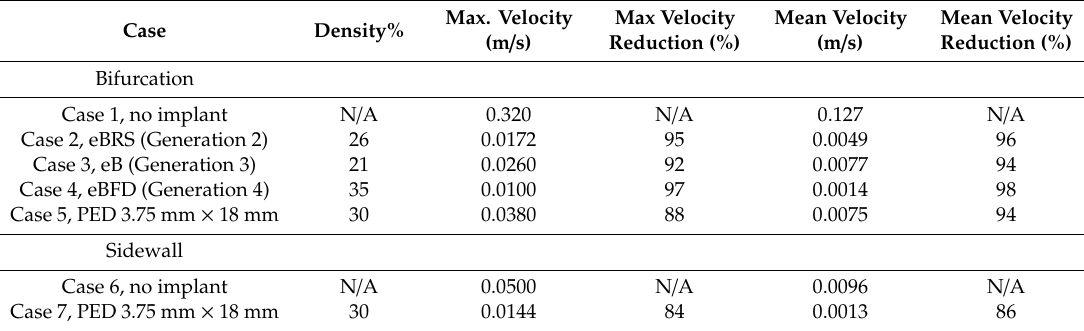
Table 2. Peak and average aneurysm velocities and the percentage of reduction for each case at 300 mL/min volumetric flow rate.